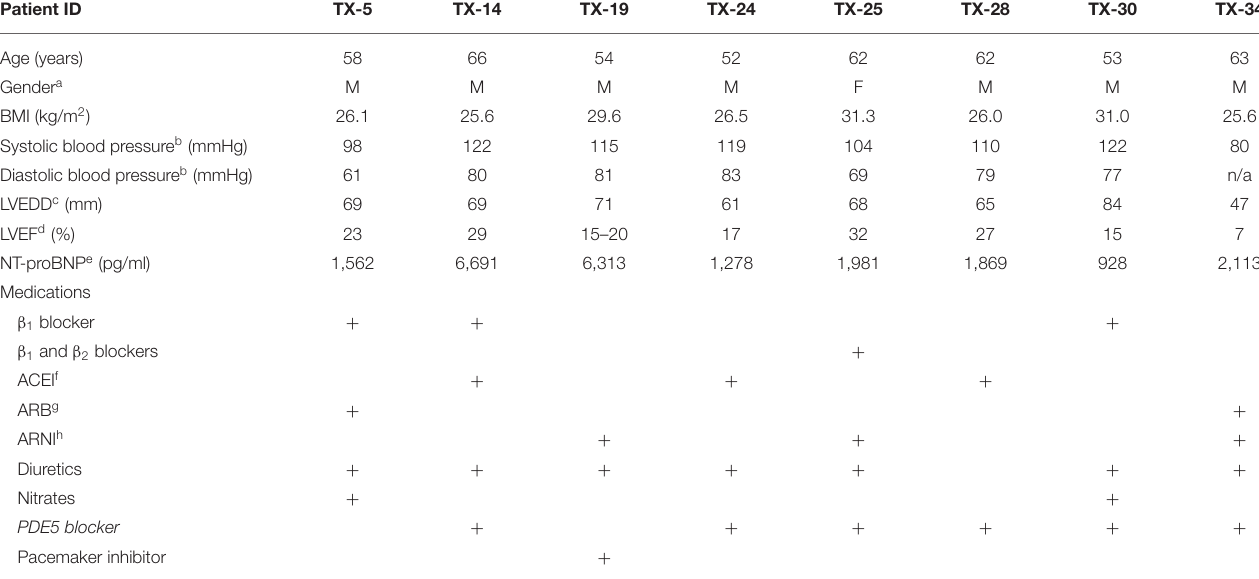
TABLE 1 | Clinical characteristics of patients with IHD. Patient